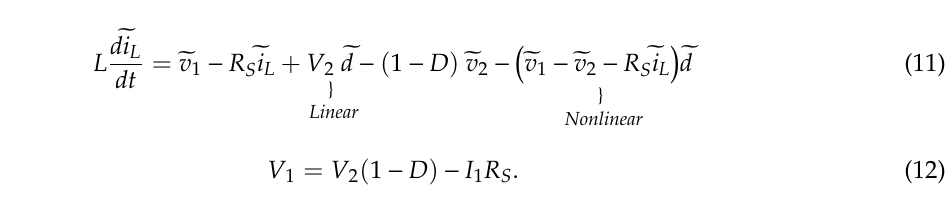
Figure 7. Circuit diagram of the BHBC operating without voltage regulation.